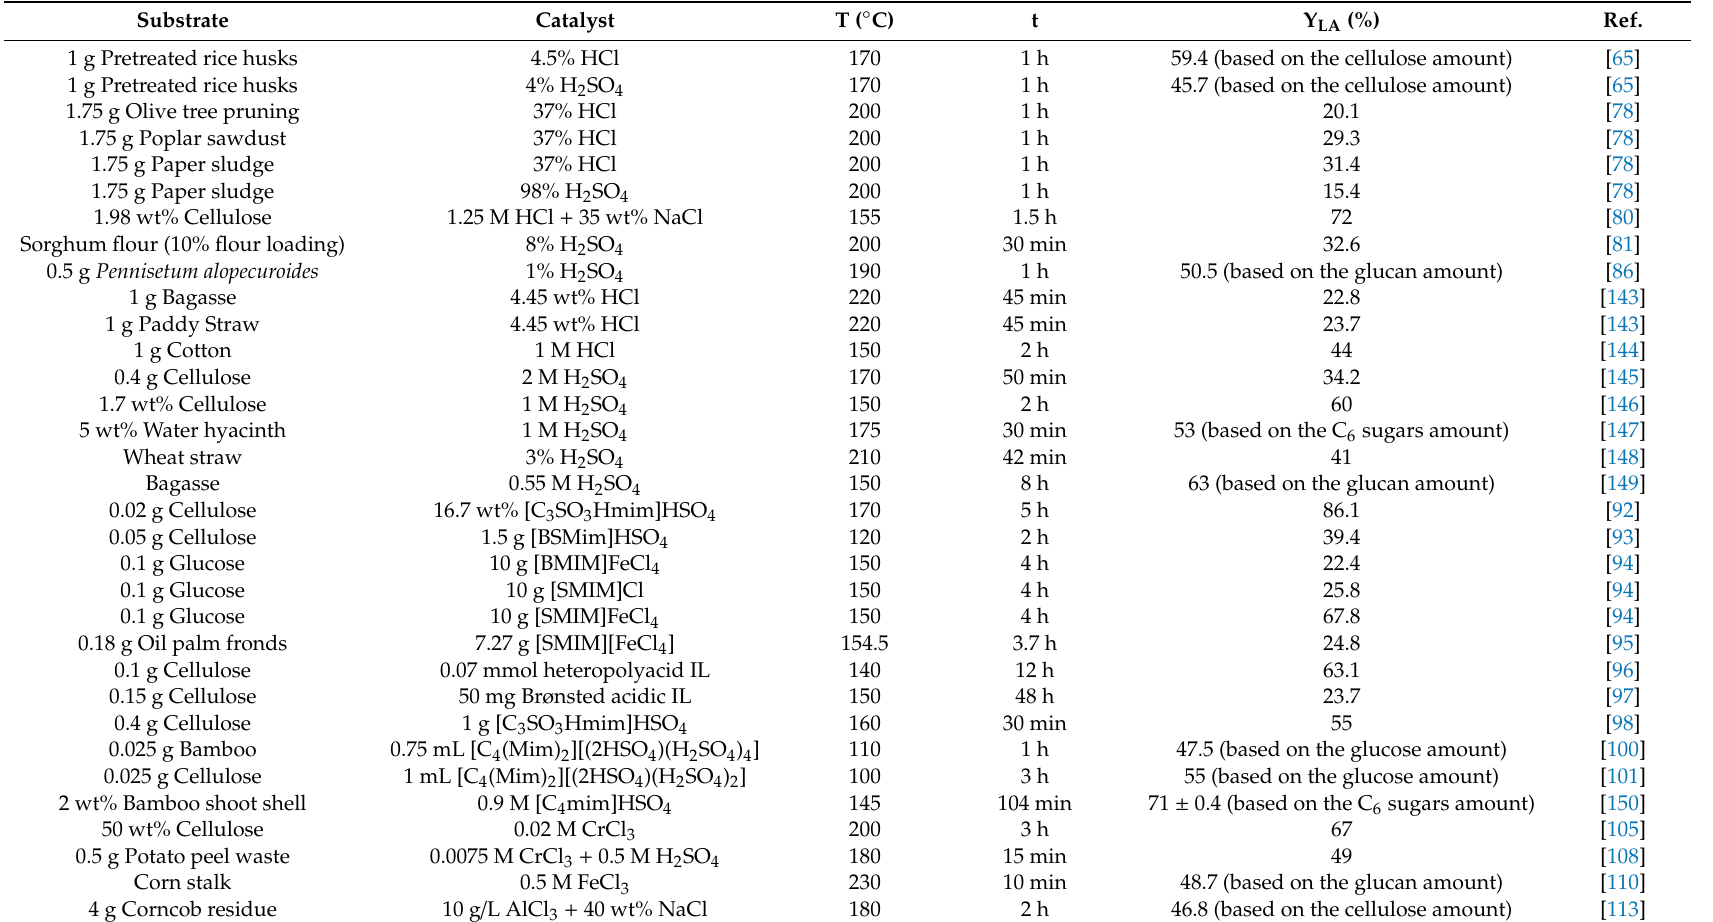
Table 2. Production of LA from biomass-derived